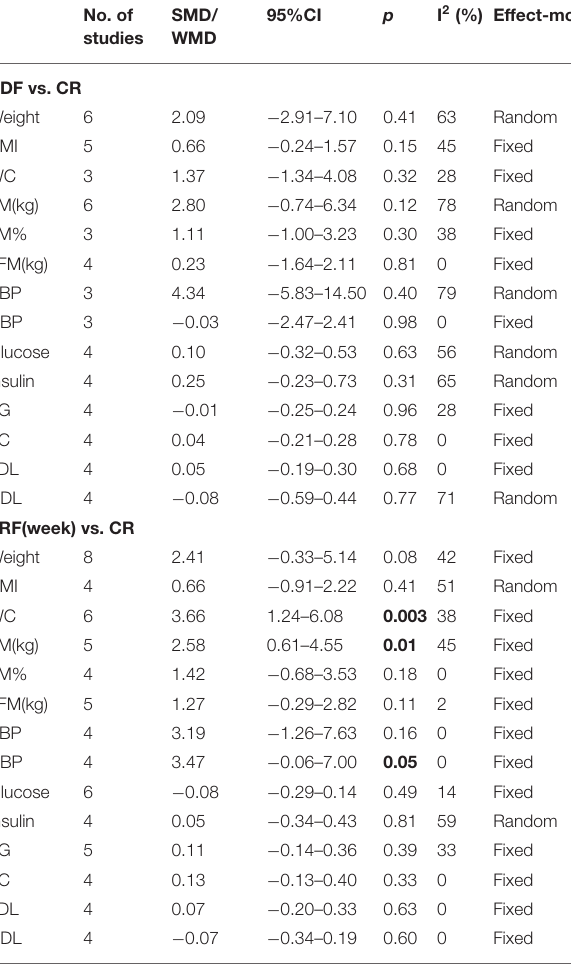
TABLE 3 | Physical and biochemical parameters of ADF vs. CR and TRF (week) vs. CR. No. of studies